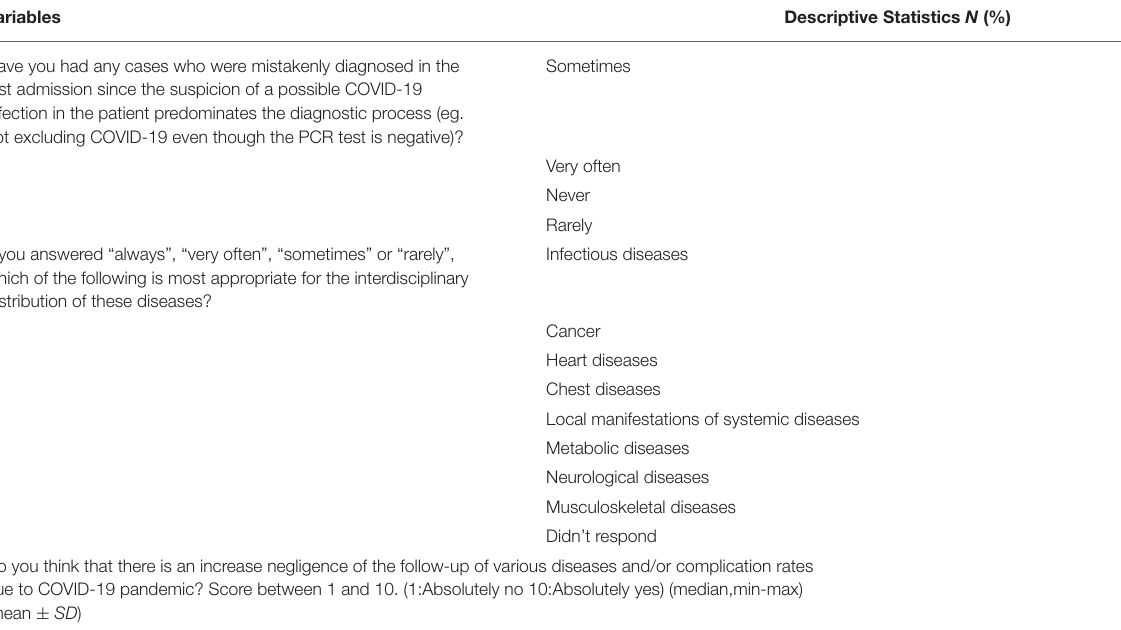
TABLE 3 | The effect of the COVID-19 pandemic on patient diagnosis and follow-up processes. Variables Descriptive Statistics N